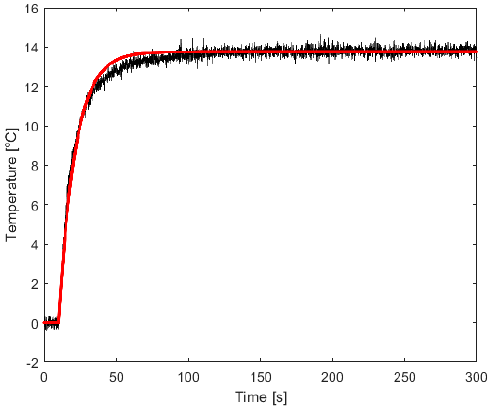
Figure 7. Measured step response ∆ T 32 (black) vs. simulated (red) of the identified model H 32 . Once the PI controller was tuned, the module was tested over 210 different working conditions (cid:4666)(cid:1846) , Δ(cid:1846)(cid:4667) with a 14 × 15 sampling matrix, where (cid:1846) ∈ (cid:4670)10 49(cid:4671) °C and Δ(cid:1846) ∈ (cid:4670)3 45(cid:4671) °C (with 3 °C steps), (cid:3030) (cid:3030) for a whole duration of approximately 52 h.